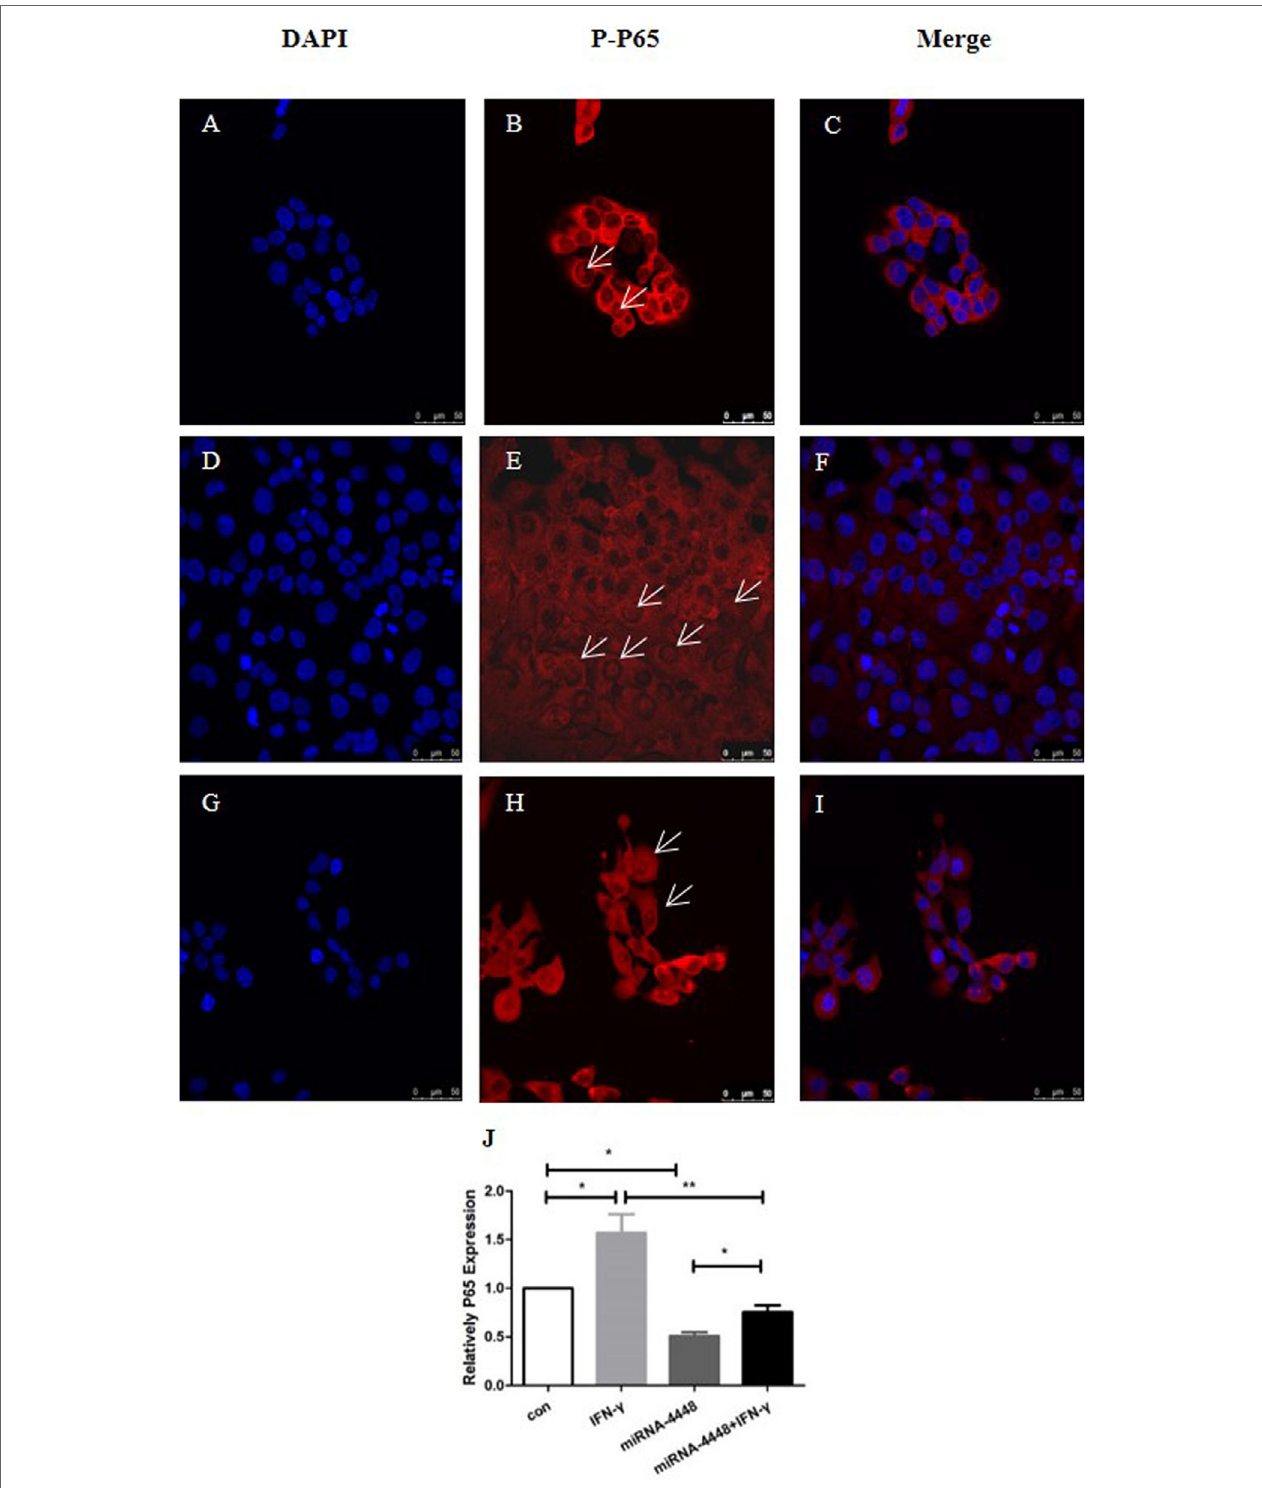
FigUre 5 | IFN- γ and miRNA4448 mediated NF κ B/P65 expression in human corneal epithelial cells (HCECs). DAPI (blue) and the activation of P65 (red) was determined by immunofluorescent staining. (a–c) There were a few P-P65 present in the nucleus of the control group (D–F) , while IFN- γ treatment increased the number of P-P65-positive nuclei. (g–i) The overexpression of miRNA4448, however, decreased the P-P65-positive nuclei, indicating the inhibition of P65. (J) P65 mRNA expression levels in the pLenti-CMV-GFP-NC and pLenti-CMV-GFP-miR-4448 HCEC lines was measured using RT-PCR. * p < 0.05; ** p < 0.01; Con and IFN- γ : pLenti-CMV-GFP-NC HCEC line. miRNA 4448 and miRNA 4448 + IFN- γ : pLenti-CMV-GFP-miR-4448 HCEC line.